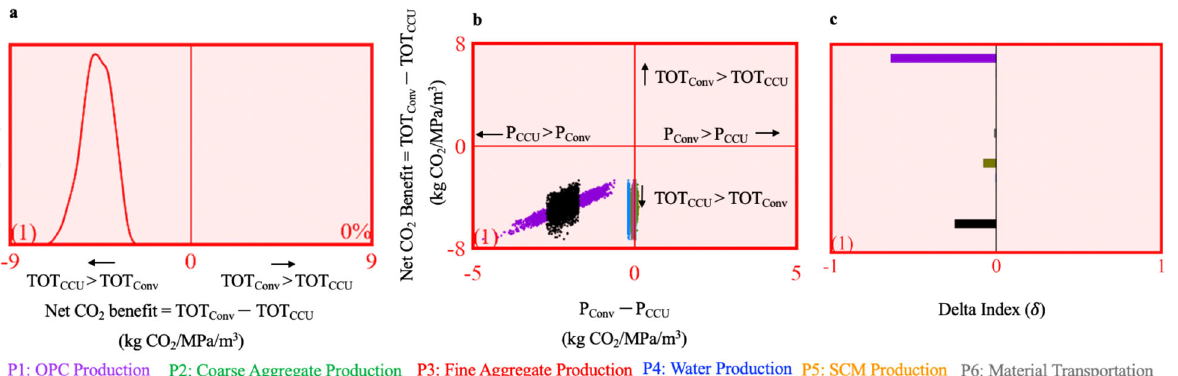
Fig. 2 Illustrative example to explain the interpretation of the results. a The distribution of the net CO 2 bene fi t of CCU concrete in 10,000 Monte Carlo runs. The net CO 2 bene fi t is the difference between the total CO 2 emissions from producing conventional concrete (TOT Conv ) and CCU concrete (TOT CCU ) b the scatter plot demonstrating the sensitivity of the net CO 2 bene fi t to the difference in the CO 2 emissions from the 13 contributing processes for conventional concrete (P Conv ) and CCU concrete (P CCU ). Positive values on the y-axis indicates that TOT Conv > TOT CCU (upper right and upper left quadrants), negative values on the y -axis indicate that TOT CCU > TOT Conv (lower right and lower left quadrants), positive values on the x -axis indicate that P Conv > P CCU (upper right and lower right quadrants), negative values on the x -axis indicate that P CCU > P Conv (upper left and lower left quadrants) c delta indices to determine the sensitivity of the net CO 2 bene fi t to the difference between the CO 2 emissions from P Conv and P CCU . The number in parenthesis represents the dataset number (from the literature review) for which the results are determined. The red background in ( a – c ) signi fi es that the net CO 2 bene fi t is negative (i.e., TOT CCU is greater than TOT Conv ) in at least 5000 out of the 10,000 Monte Carlo runs (i.e., likelihood greater than 50%). If the background is green, then it signi fi es that the net CO 2 bene fi t is positive with a likelihood greater than